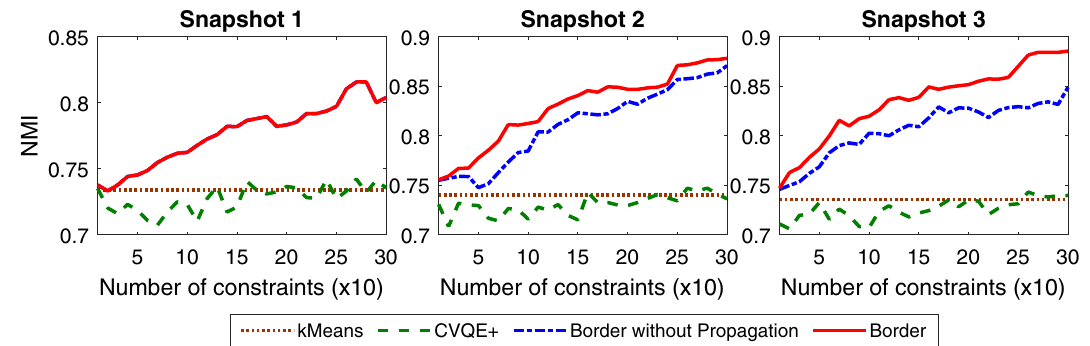
Fig. 13 Temporal clustering on the dataset Optdigits